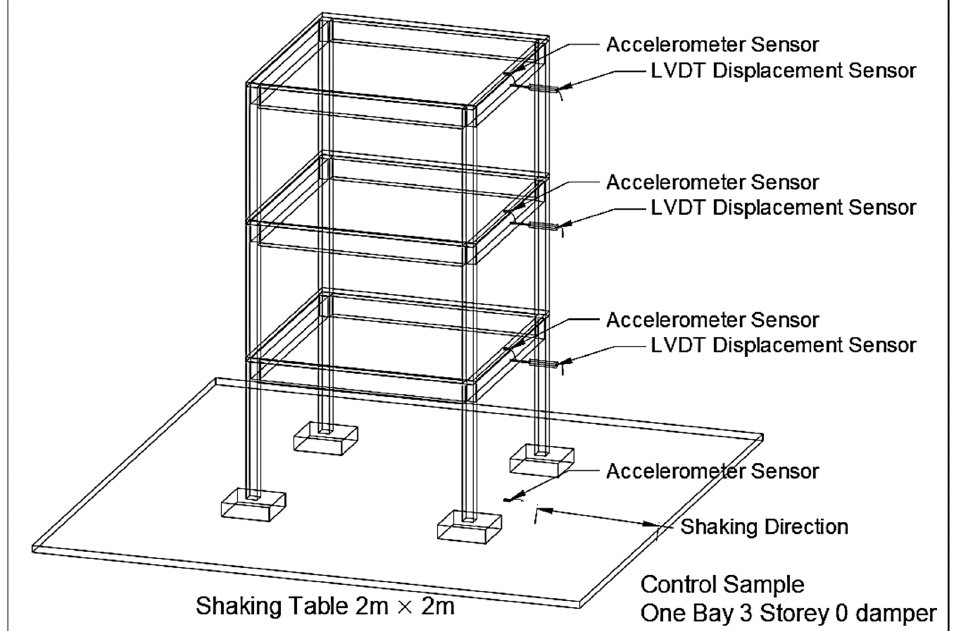
Figure 5. Placement of accelerometer and LVDT.